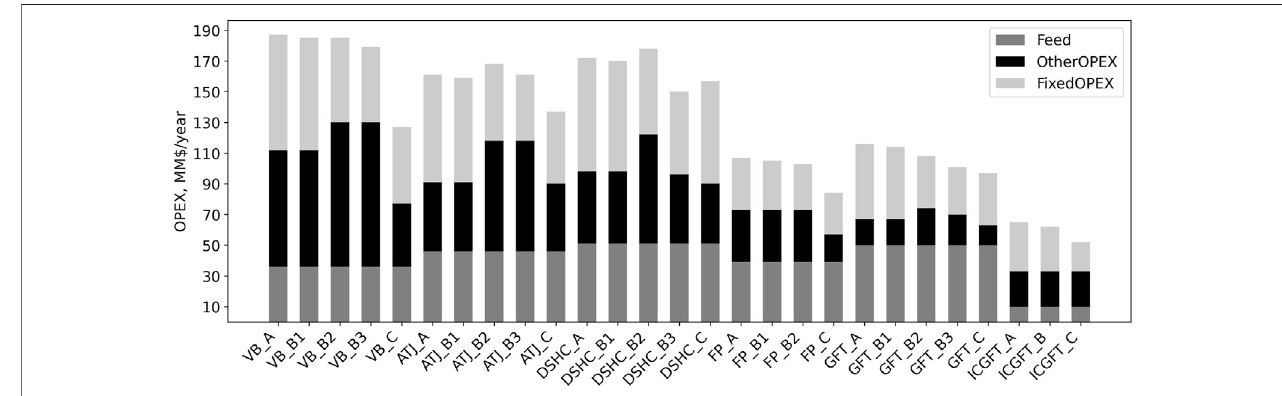
FIGURE5| ComparisonofOPEXcomponentsofintegratedscenarioswiththeirrespectivestandalonescenarios(VB_A/ATJ_A/DSHC_A/FP_A/GFT_A/ICGFT_A).